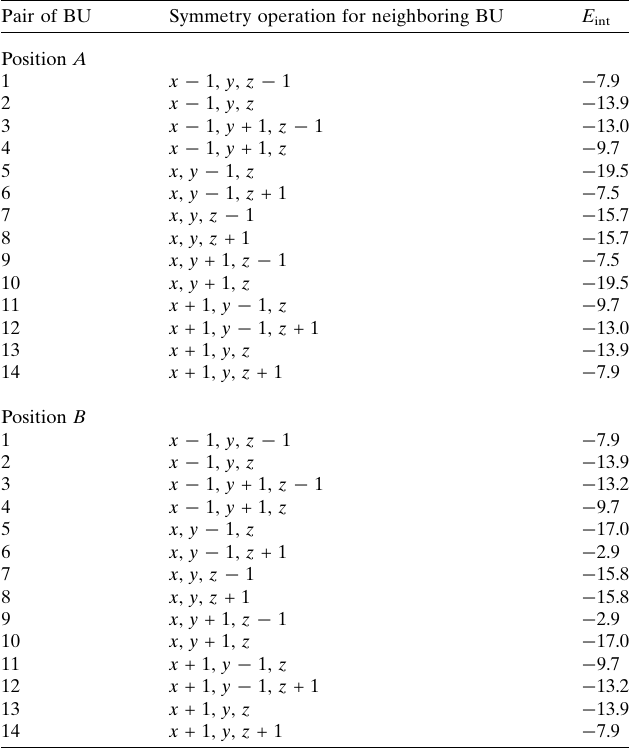
Table 3 Symmetry codes, binding types and interaction energies of the building units (BU) (kcal mol (cid:4) 1 ) (tetramers) with neighbors. Pair of BU Symmetry operation for neighboring BU E int Position A 1